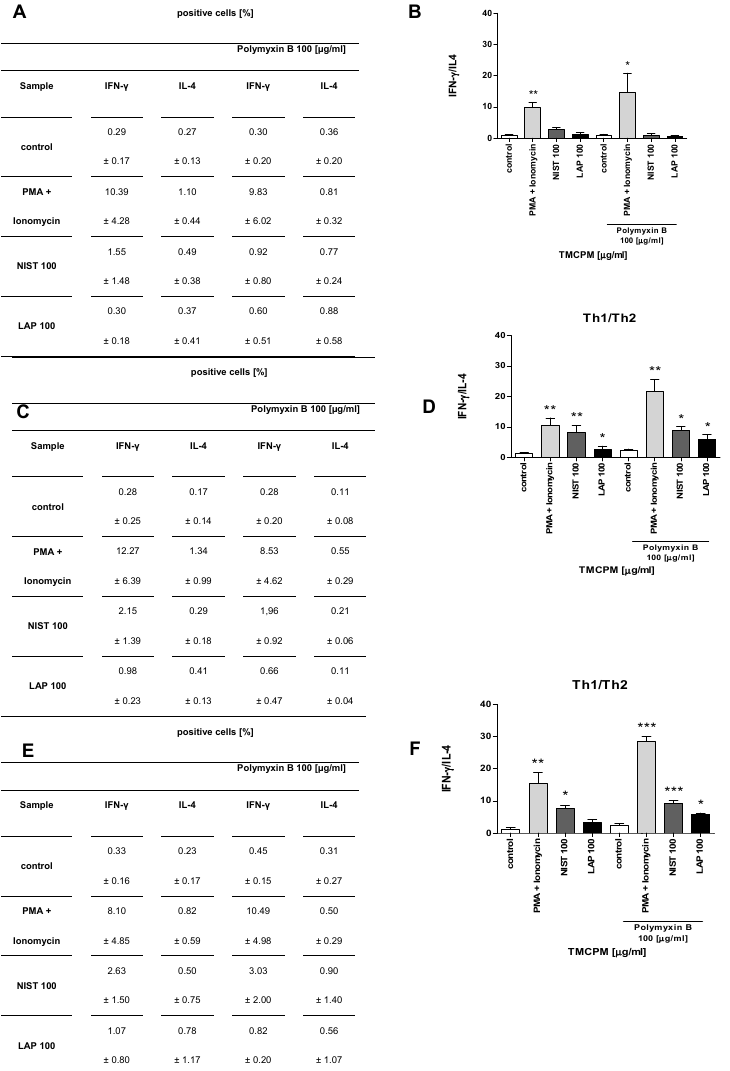
Figure 7. E ff ect of the exposition of T lymphocytes ( A , B ), PBMC ( C , D ) and T lymphocytes with monocytes added ( E , F ) to TMCPM (NIST or LAP) pre-treated with polymyxin B on the Th1 / Th2 ratio. Cells were stimulated as described in “Materials and Methods” with PMA (50 ng / mL) + ionomycin (100 ng / mL) (positive control) or with NIST or LAP (100 µ g / mL) pre-treated with polymyxin B (100 µ g / mL). ( A , C , E ) Percentage of Th1, Th2, Th17, and Treg cells was quantified as the frequency of cells positive for IFN- γ , IL-4, IL-17A, and FoxP3, respectively. ( B , D , F ) The frequency ratio (%) of IFN- γ positive to IL-4 positive CD4 + T cells (Th1 / Th2) was calculated. Data are presented as mean ± SEM from four independent experiments performed. Di ff erences between the groups were considered statistically significant at the following p values: * p < 0.1, ** p < 0.01, *** p <